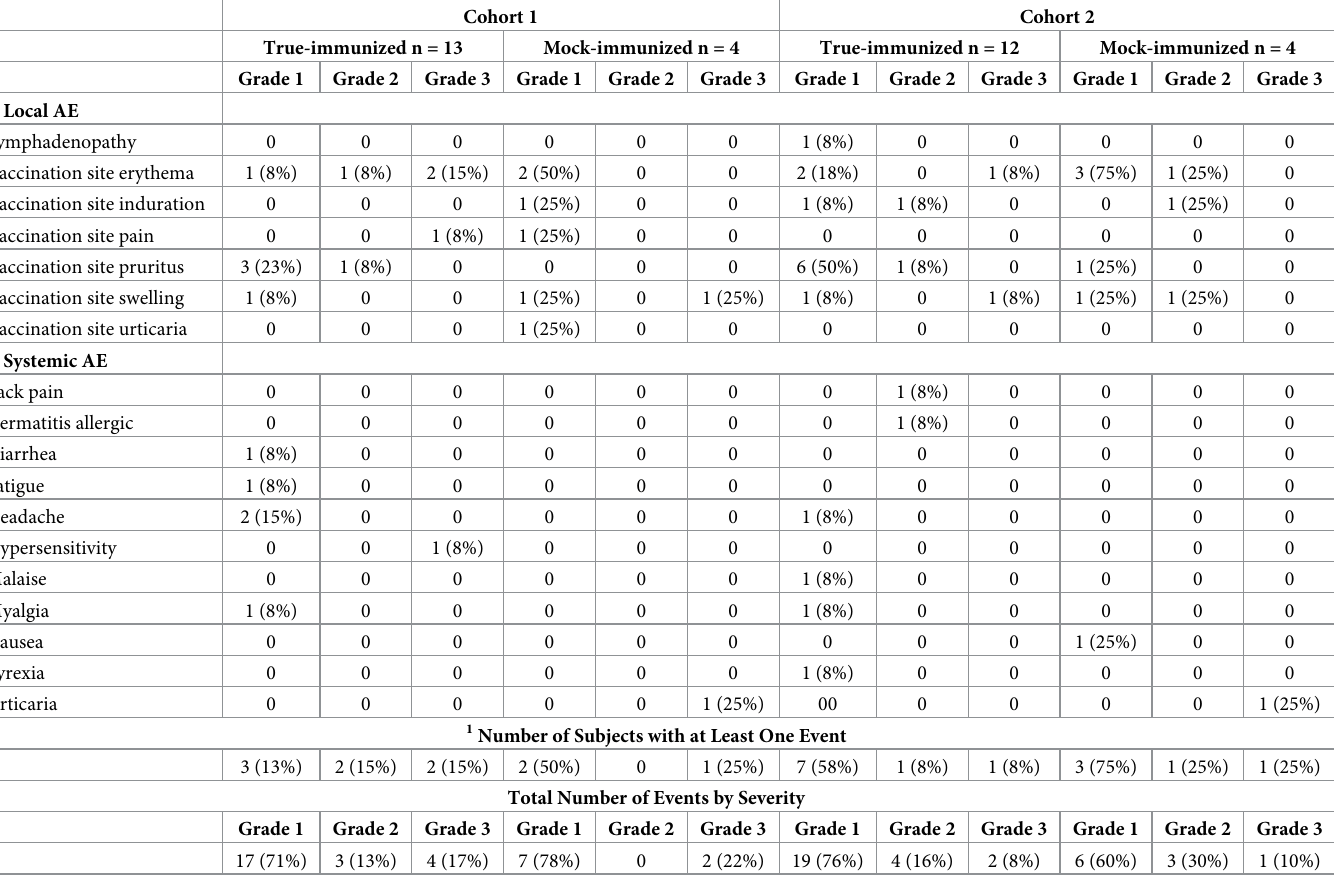
Table 2. Solicited adverse events occurring within 7 days of any immunization for all subjects receiving at least one